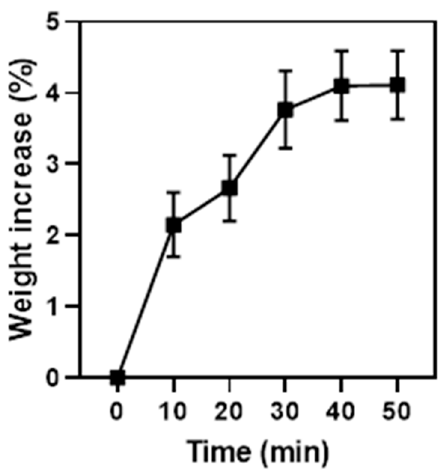
Figure 6. Hygroscopicity evaluation: BioQ-CPX weight increase percentage as a function of incubation time; mean ± SE ( n = 6).